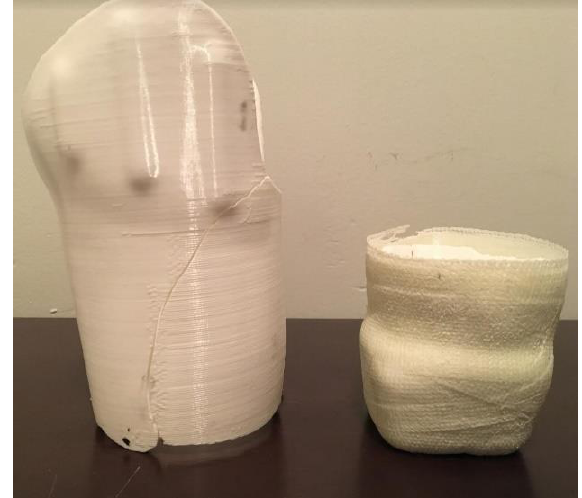
Figure 7: Complete Socket